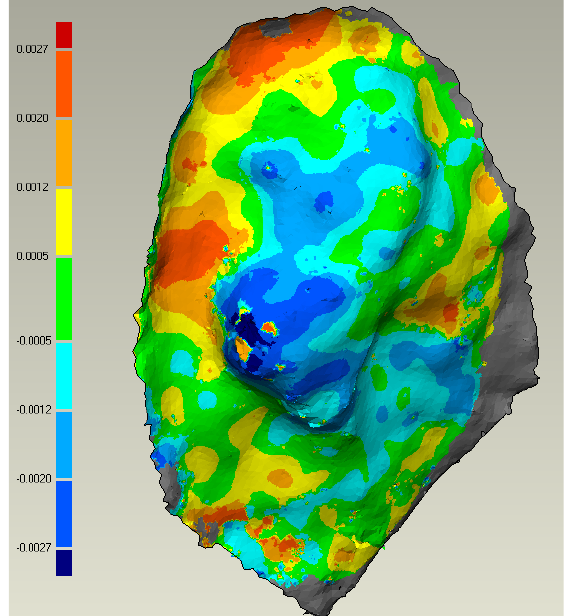
Figure 12. The surface comparison of models from the first and second test cases. Because of a nonoptimal imaging geometry in the second test case, the depth scale is incorrect, making the object flat. In addition, this model is noisy. The unit is metres.